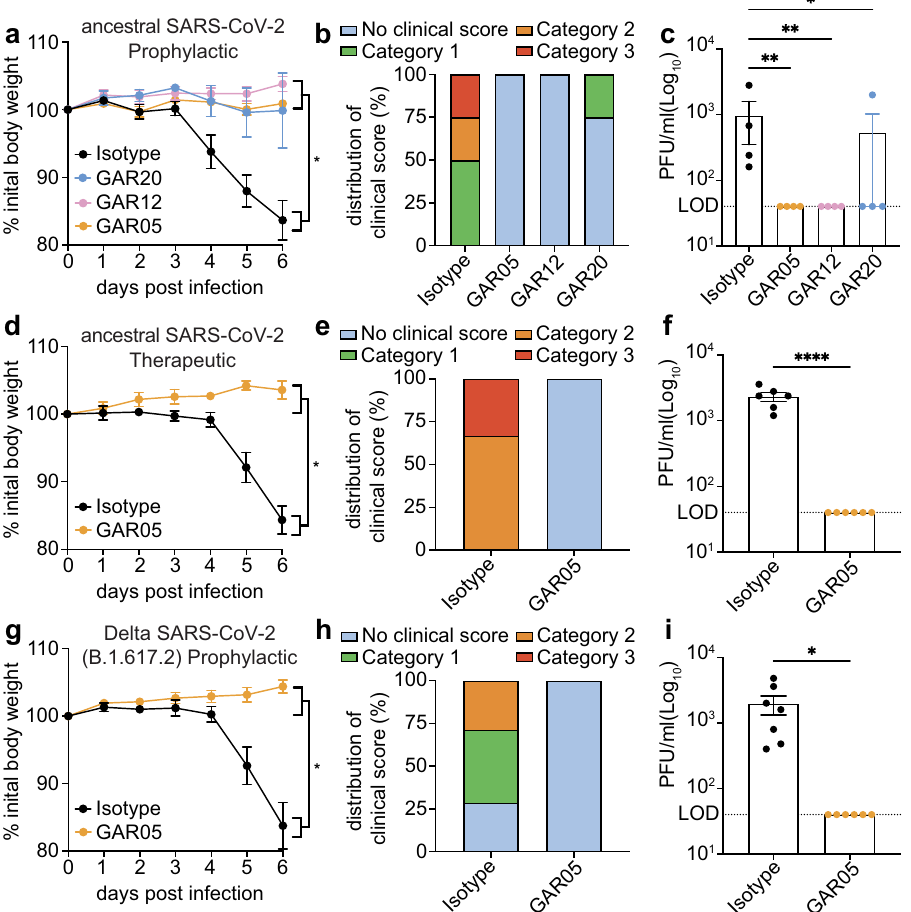
Fig. 4 | Protection of K18-hACE2 mice from live viral challenge. Animals were injected interperitoneally with 30mg/kg of GAR05, GAR12, GAR20 or human IgG1 isotype control 3 days prior to viral challenge (-3 dpi) for prophylactic studies ( a – c , g – i ) or +1 dpi post challenge for therapeutic studies ( d – f ). Mice were chal- lenged (d0) with 1×10 3 PFU of intranasal ancestral SARS-CoV-2 or Delta VOC (B.1.167.2)virusandmonitoredfor6days,andeuthanized(d6)fortissuecollection. Measurements of weight (percentage loss from initial weight, a [ n =4 mice per group measured on 6 consecutive days. 2-way ANOVA with Tukey ’ s multiple comparisons test. * p <0.05], d [ n =6 mice per group measured on 6 consecutive days. A single isotype control mouse was removed from the study on day 5 as it